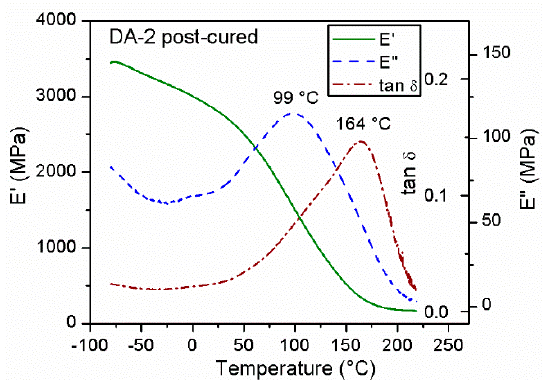
Figure 5. DMA thermogram of post-cured DA-2.